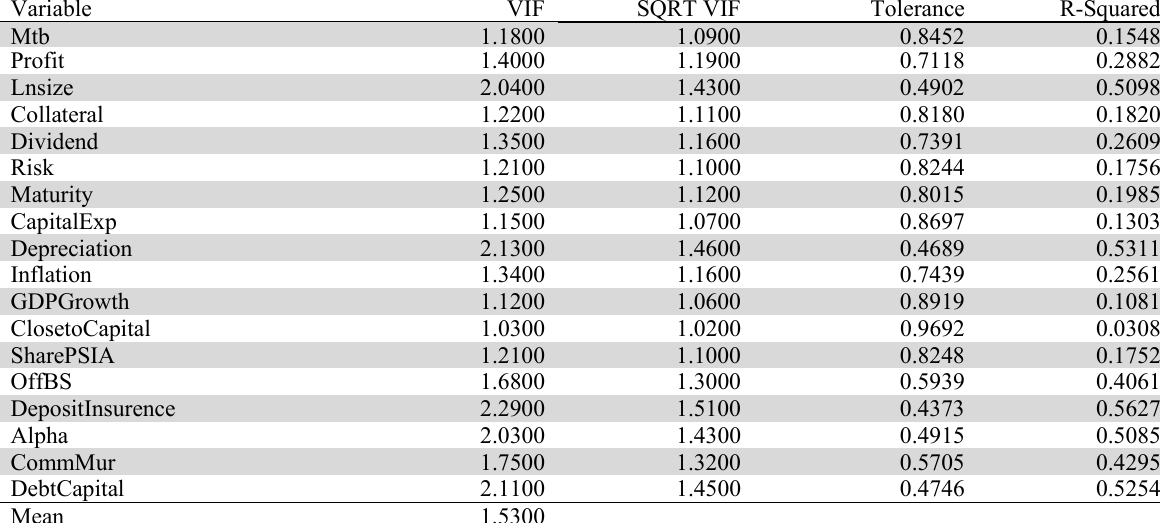
Variance Inflation Factors of selected variables (VIF) (2008-2017) Variable VIF